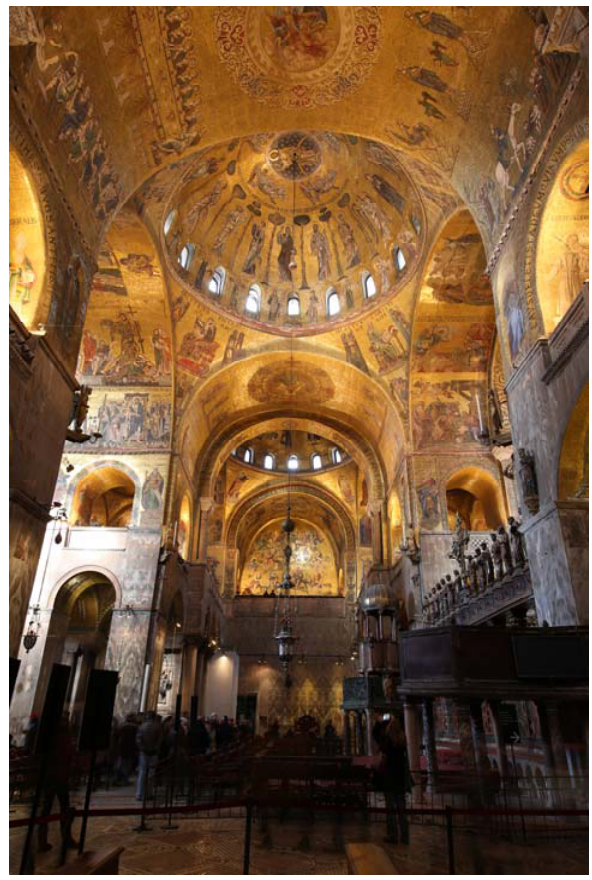
Figure 1: image of the interior of the Basilica from where